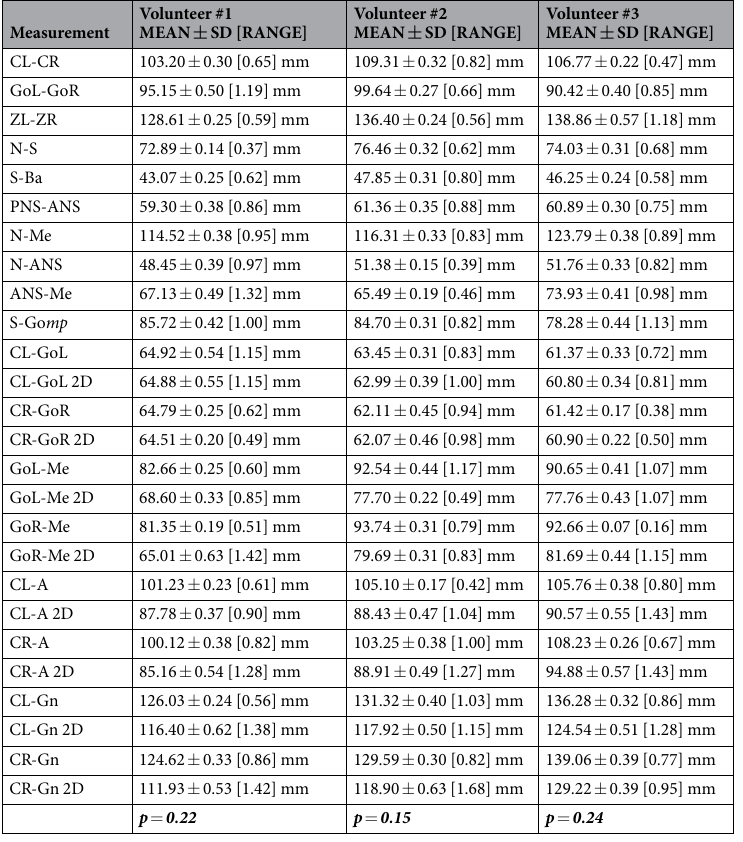
allows for 3D high resolution imaging and suppression of susceptibility artifacts at the same time 43 . It was specif- ically optimized and evaluated for craniofacial MRI, as described elsewhere 15 . Sequence parameters were: echo time: 5.8 ms, repetition time: 800 ms, bandwidth: 625 Hz/pixel, number of averages: 1, echo train length: 100, field of view: 171 mm × 171 mm, acquisition matrix: 320 × 320, voxel size: 0.53 mm × 0.53 mm × 0.53 mm, number of sections: 256, time of acquisition: 7:01 min. For accuracy measurements, the Lego phantom was placed in a waterproof plastic box (Lock & Lock, Seoul, South Korea) and fixed in position using silicon impression material (Optosil Comfort, Kulzer GmbH, Hanau, Germany). The plastic box was filled with water and gadoterate (Gd) meglumine contrast (Dotarem ® , Guerbet, France) in a ratio of 1:250 to enhance signal from water. Next, the phantom was scanned in 3 positions: 1. “Normal”: Regular alignment in x-, y- and z-direction; 2. “Rotated”: Deviation in x- and z-direction; 3. “Rotated and lifted”: Deviation in x-, y- and z-direction. This setup of phantom scans is illustrated in Fig. 1.